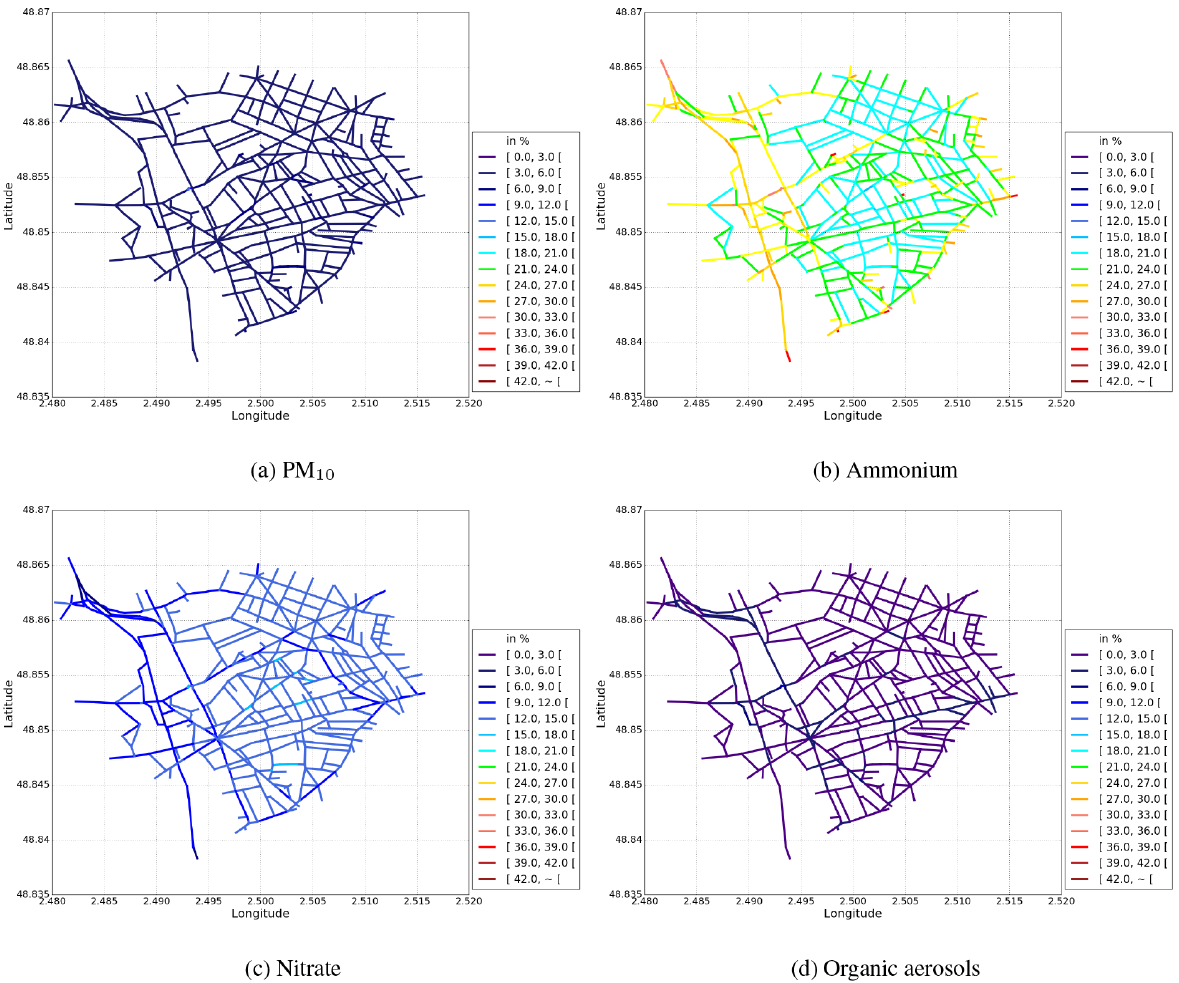
Figure 11. Temporal NME (in %) between Case-1 and Case-5 for (a) PM 10 , (b) ammonium, (c) nitrate, and (d) organic aerosols. The absolute differences in the concentrations between the simulations are presented in additional figures in Appendix